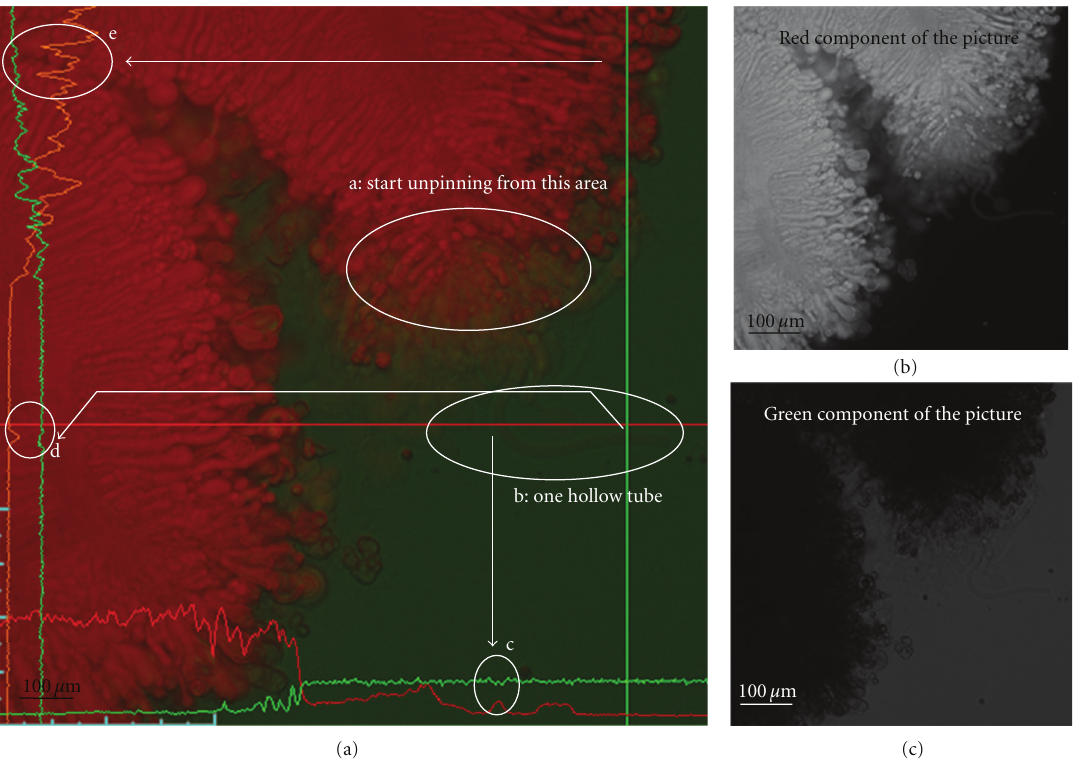
Figure 5: POPC, 1 mol% TR-DHPE, room temperature, hydrate solution of fluorescein/DI water 5 × 10 − 4 mg/mL Fluorescein. (a) Shows the two-color image; (b) and (c) are the same image with only one-color component (red (lipid) or green (water)). Region a: in (a) shows the area where the plaque of lipid start unpinning from the substrate. So, the myelin figures growing from that area have a hollow shape. Region b: shows one of these hollow tubes. (Circles c and d) refer to the intensity of two areas in the hollow tube which can be compared with the environment of a solid tube (Circle